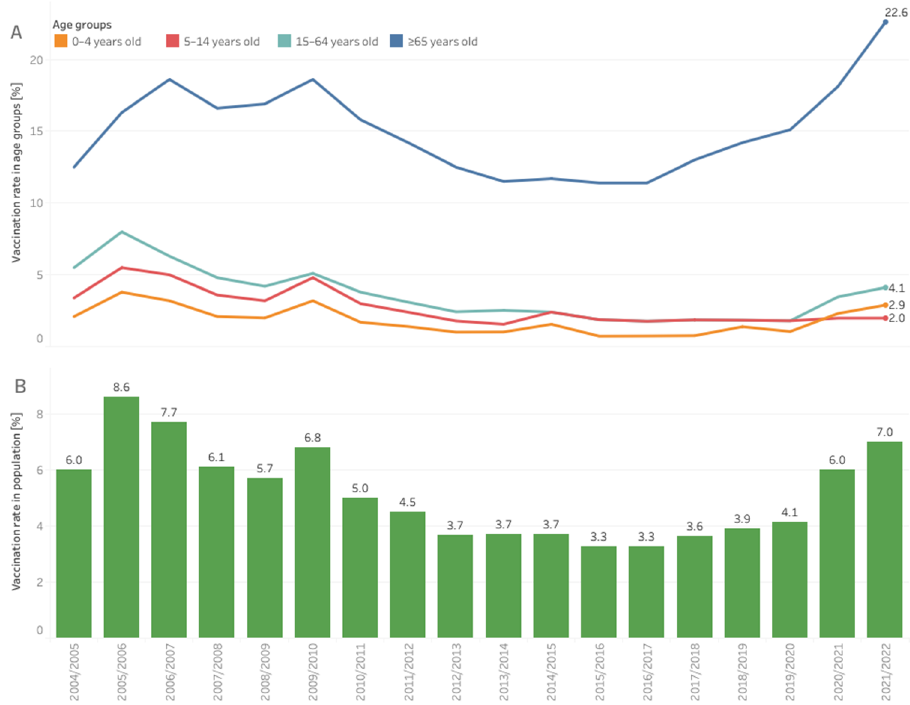
Figure 1. Influenza vaccination coverage in Poland in individual age groups, ( A ) the entire population, ( B ) in influenza seasons from the beginning of the XXI century. Market estimates based on data from distributors and the National Institute of Public Health.